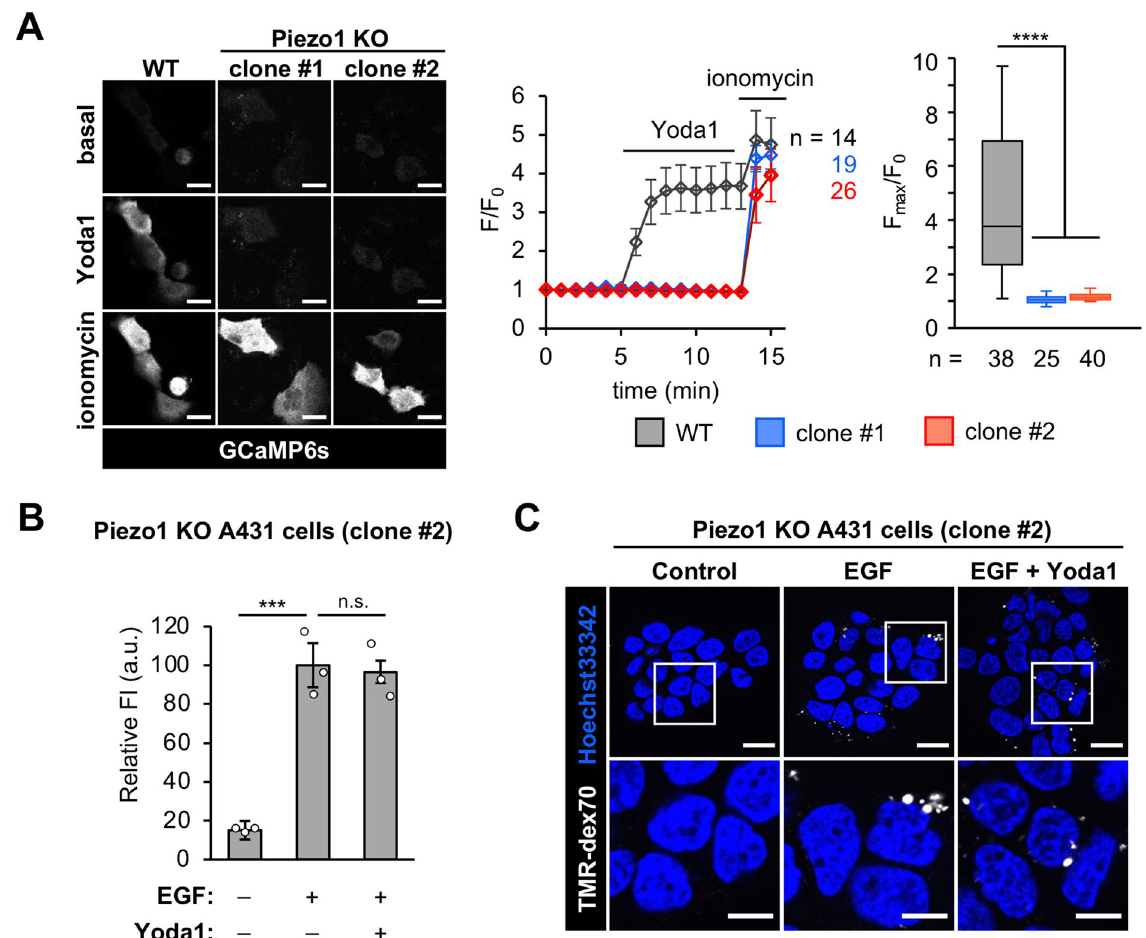
Figure 2. Macropinocytosis inhibition by Yoda1 is Piezo1-dependent. ( A ) GCaMP6s fluorescence intensities in WT, Piezo1-KO clone#1 and clone #2 cells were recorded every 1 min. Yoda1 (1.5 µM) and ionomycin (5 µM) were added at 5 and 13 min after start of time-lapse imaging, respectively. Left: Representative images of GCaMP6s-expressing cells before and after addition of Yoda1 and ionomycin. Middle: Representative time-course of relative fluorescence intensity of GCaMP6s. Right: Quantification of maximum Yoda1-induced GCaMP6s intensity increase. Box and whiskers graph: line, median; box, upper and lower quartiles; whiskers, maxima and minima. ( B ) Flow cytometry analysis of EGF-stimulated TMR-dex70 uptake into Piezo1-KO A431 cells (clone #2) in the absence or presence of Yoda1 (1.5 µM) for 10 min. ( C ) Observation of EGF-stimulated TMR-dex70 uptake into Piezo1-KO A431 cells treated as ( B ). The bottom images show enlarged views of the areas outlined by the white squares in the top images. Data represent the mean ± s.e.m. (n = 3 independent biological replicates in ( B ); n = 14, 19, 26 cells for WT, clone #1 and #2, respectively) in ( A , middle). Data represent in box plot (from left to right, n = 38, 25, 40 cells pooled from two independent experiments) in ( A , right). ***p < 0.001; ****p < 0.0001; n.s. not significant [one-way ANOVA followed by Dunnett’s post hoc test ( A ) or one-way ANOVA followed by Tukey–Kramer’s post hoc test ( B )]. Scale bars, ( C , top) 20 µm; ( C , bottom) 10